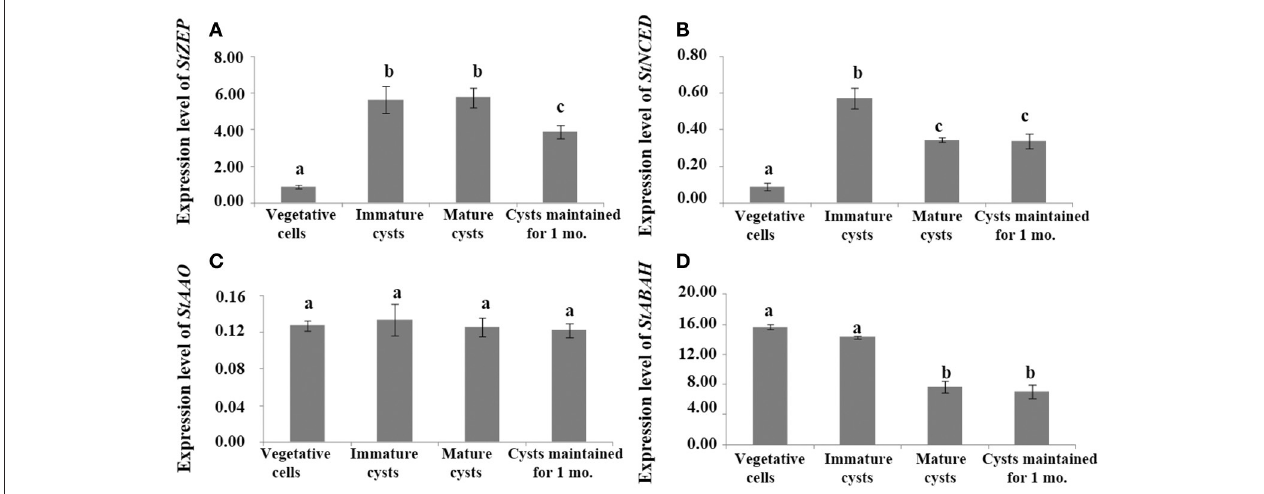
FIGURE 2 | The transcript levels of genes associated with ABA biosynthesis and catabolism, (A) StZEP (B) StNCED (C) StAAO (D) StABAH , relative to the reference gene MDH in cells at different stages of life cycle (vegetative cells, immature cysts, mature cysts, and cysts maintained for 1 month). Significant differences in abundance are indicated with different letters above bars at p < 0.05; same letter denotes no significant difference. Values are presented as mean ± standard deviation, Error Bars = SD, n = 3.